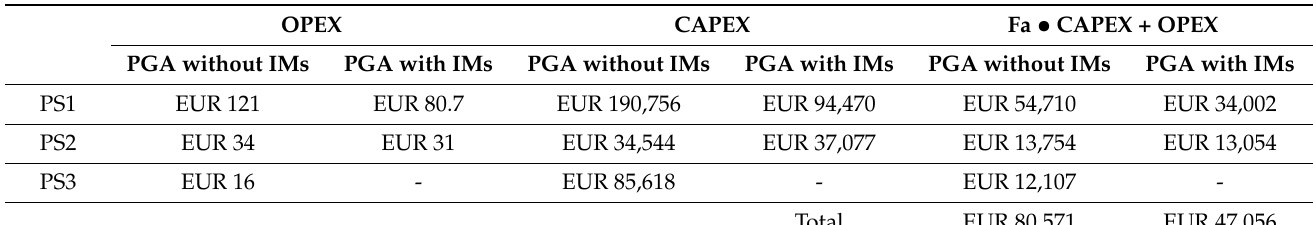
Table 2. Cost comparison between the best solutions with and without IMs.